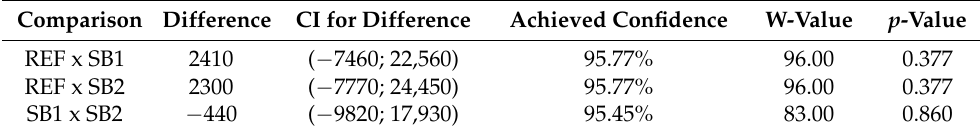
Table 4. Comparative evaluation of each pair of groups of asphalt mixtures using the Mann–Whitney U